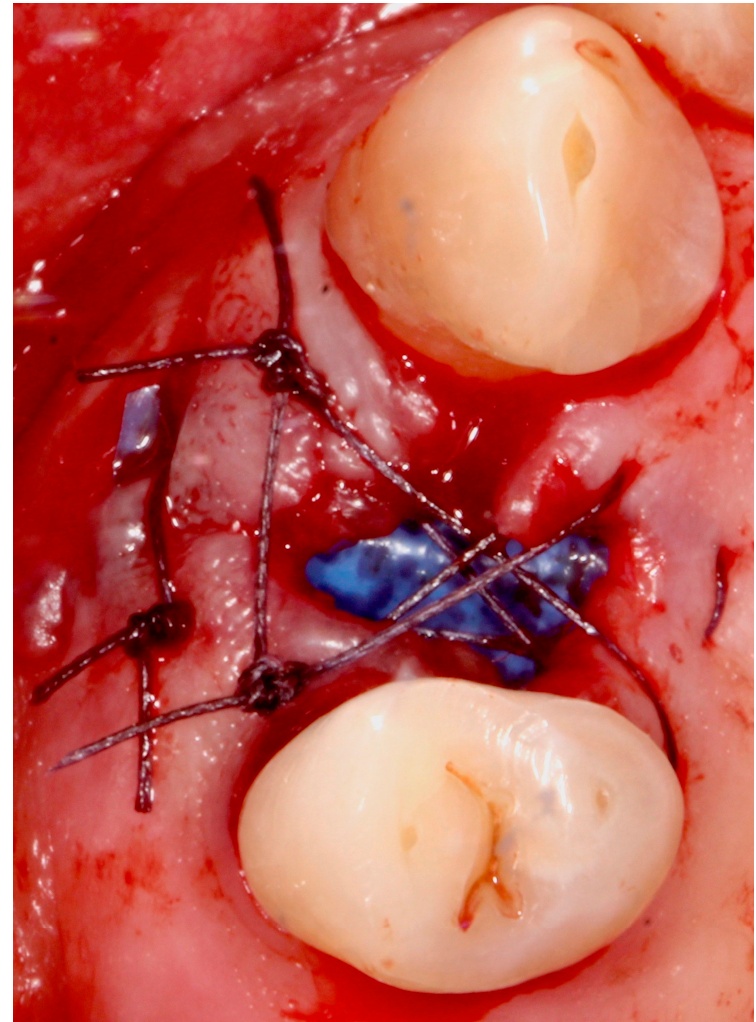
Figure 4. Membrane stabilization by sutures.